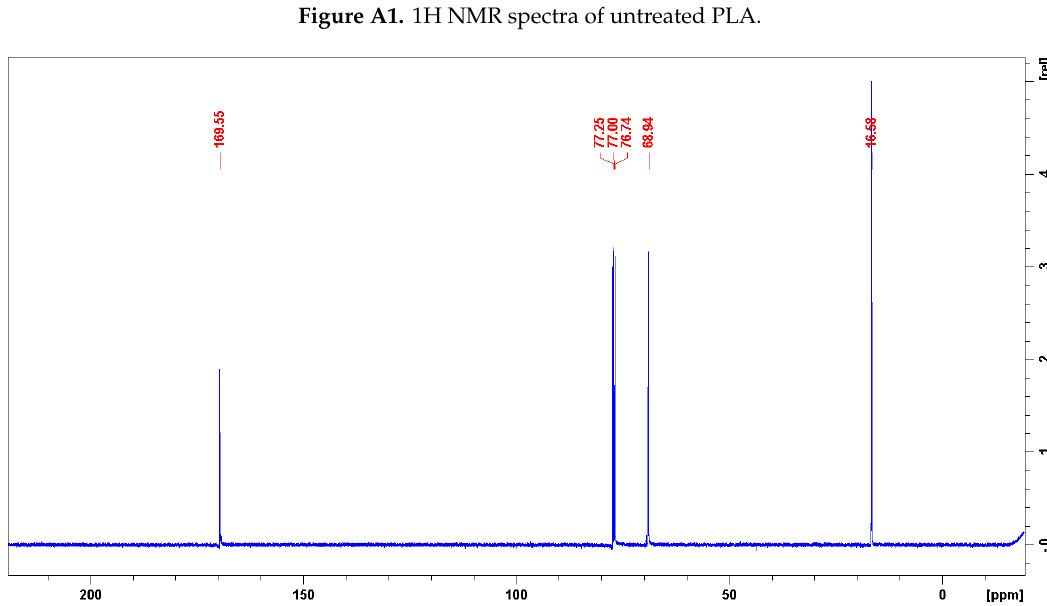
Figure A2. 13C NMR spectra of untreated PLA.